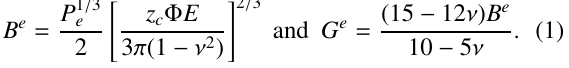
Figure 2. Views of slices (thickness 3 d ) cut through simulated systems compressed to P ⇤ = 0 . 1 (near initial states of compres- sion in Fig. 1). Left:  = 0 . 359, z c = 4 . 50, z d  = 0 . 319, z c = 4 . 73, z d = 0 . 29.